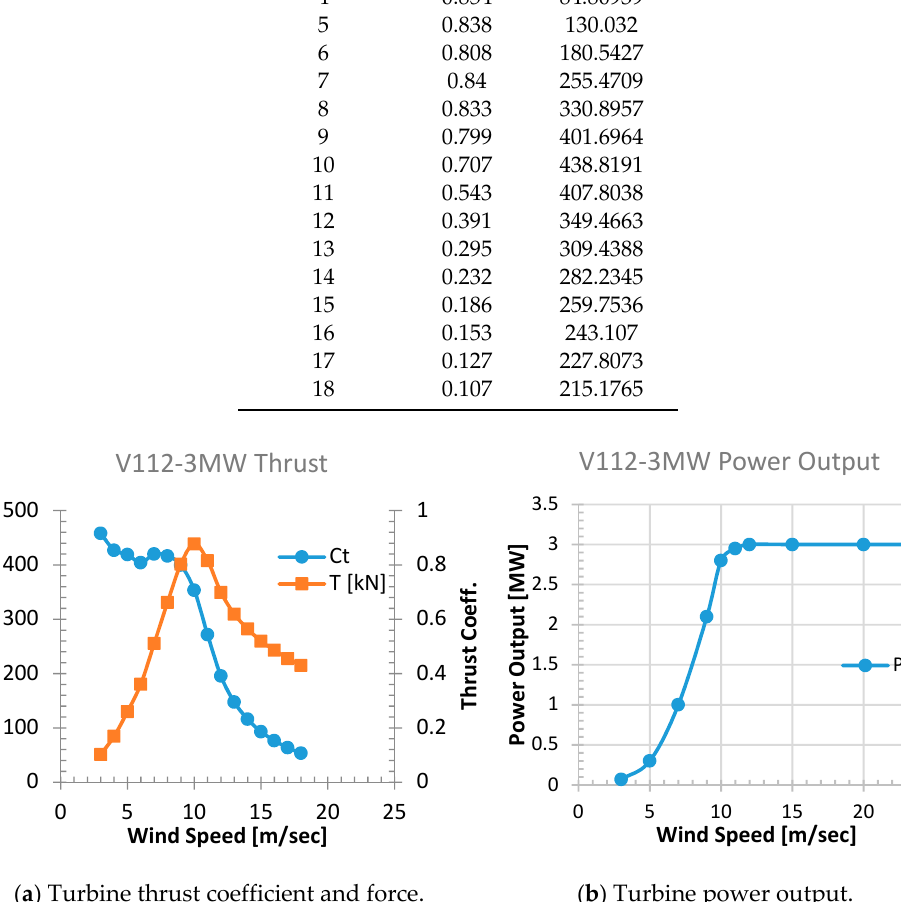
Figure 11. V112-3MW turbine thrust force, thrust coefficient, and power output.